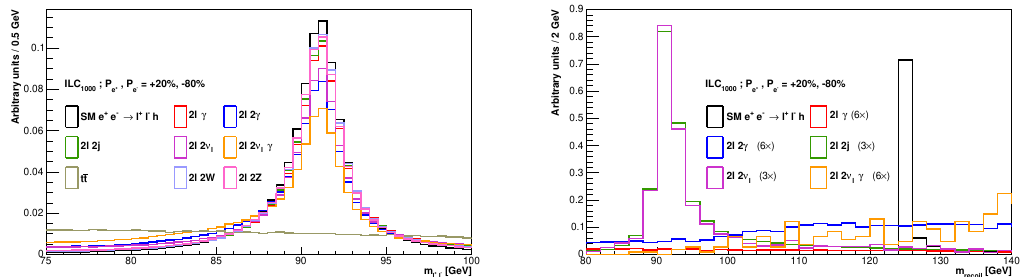
Figure 4. Some plots of the ILC 1000 Zh selection with the left polarisation for the SM-driven e + e − → ‘ + ‘ − h (black), 2 ‘γ (red), 2 ‘ 2 γ (blue), 2 ‘ 2 j (green), 2 ‘ 2 ν ‘ (magenta), 2 ‘ 2 ν ‘ γ (orange), tt (brown), 2 ‘ 2 W (lilac), and 2 ‘ 2 Z (pink) processes. All histograms are normalised to unity. Left: m distribution, peaking at the Z -boson mass, before applying the m ‘ + ‘ − Right: m recoil distribution, with the black curve peaking narrowly at m h on top of a continuum background, before requiring m recoil ∈ [123 . 0 , 127 . 0] GeV. At this stage of the selection the tt background is already negligible, and the distributions of the 2 ‘ 2 V processes lie beyond the right edge of the plot. Some histograms in the right panel are scaled ( 3 × or 6 × ) after normalisation for visualisation